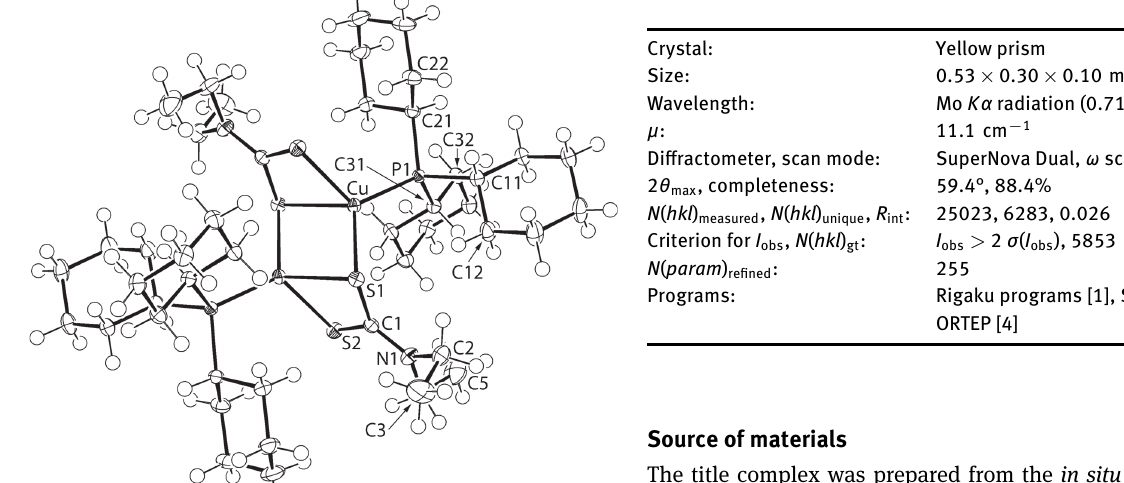
Table 1: Data collection and